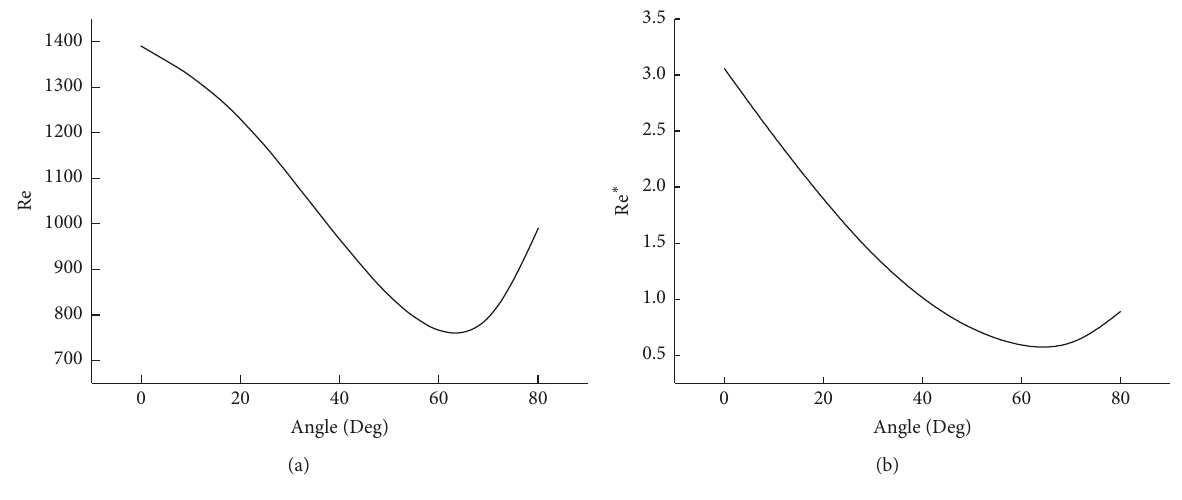
Figure 5: Reynolds number of oil film: (a) Re; (b) Re ∗